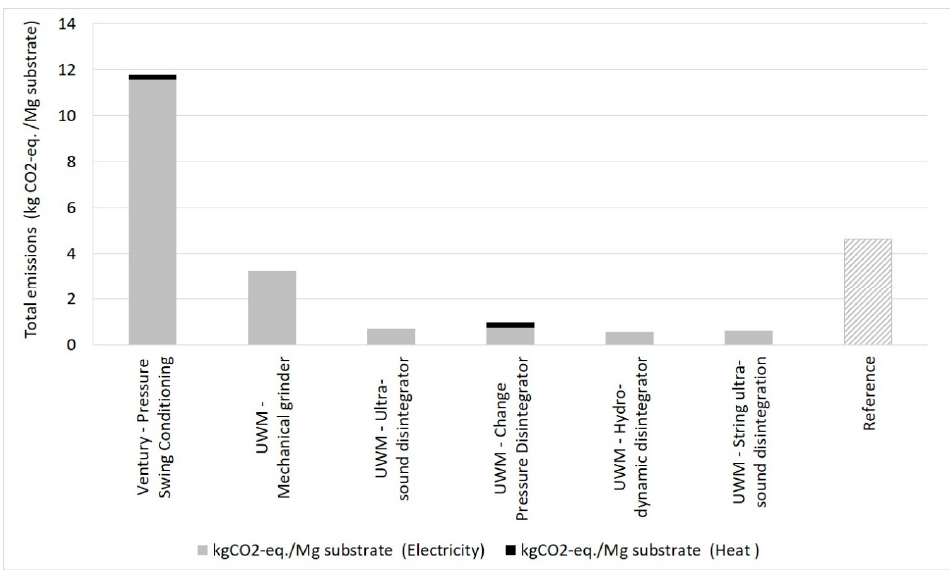
Figure 6. GHG emissions for pre-treatment technologies per Mg Substrate (fresh matter).